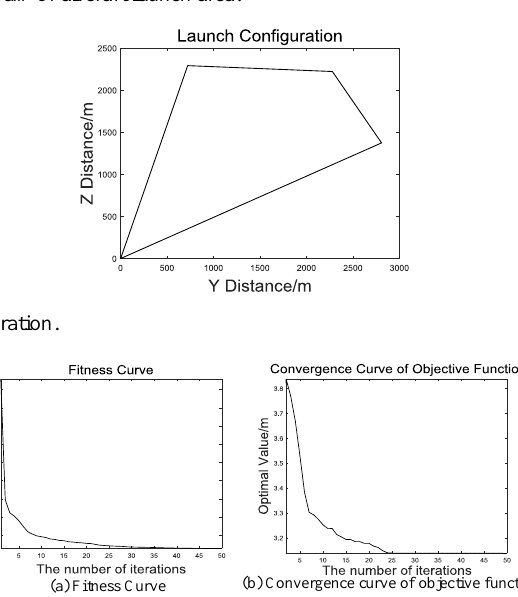
Fig. 7. Population mean fitness and target